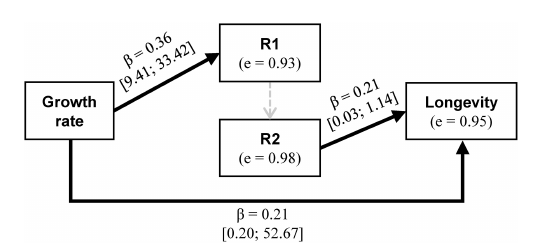
FIGURE4 Path analysis diagram describing the direct and indirect effects of growth rate on fecundity and adult longevity (best one of four tested; see Supplementary Figure 1 in Supplementary material for other diagrams). Arrows with solid black lines represent significant ( p -value < 0.05) links, arrows with dashed lines represent links tested but insignificant. When the relationship was significant, the standardized coefficient ( β ) and 95% confidence interval of the non-standardized coefficient are given. Errors (e) are given for each endogenous variable as √ (1- R 2 ).